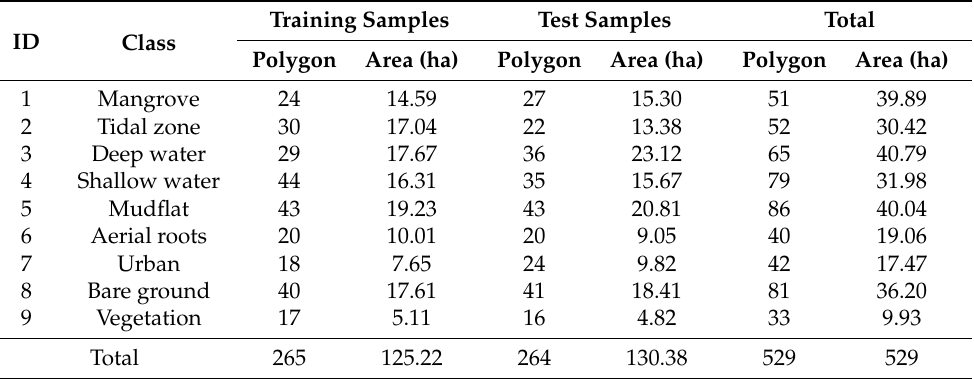
Table 1. The number and area of training and test polygons for nine classes that were considered in this